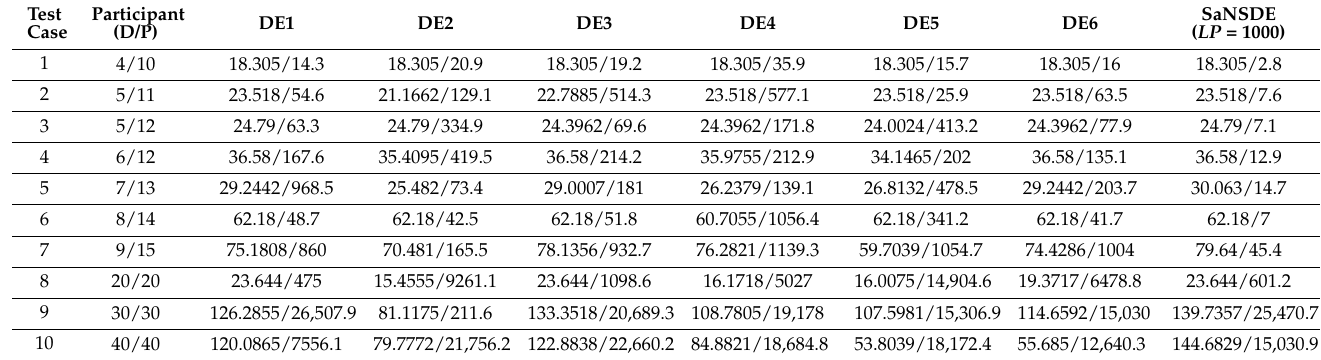
Table 18. Average fitness values and average number of generations for DE with six strategies and SaNSDE with algorithmic parameter LP = 1000.